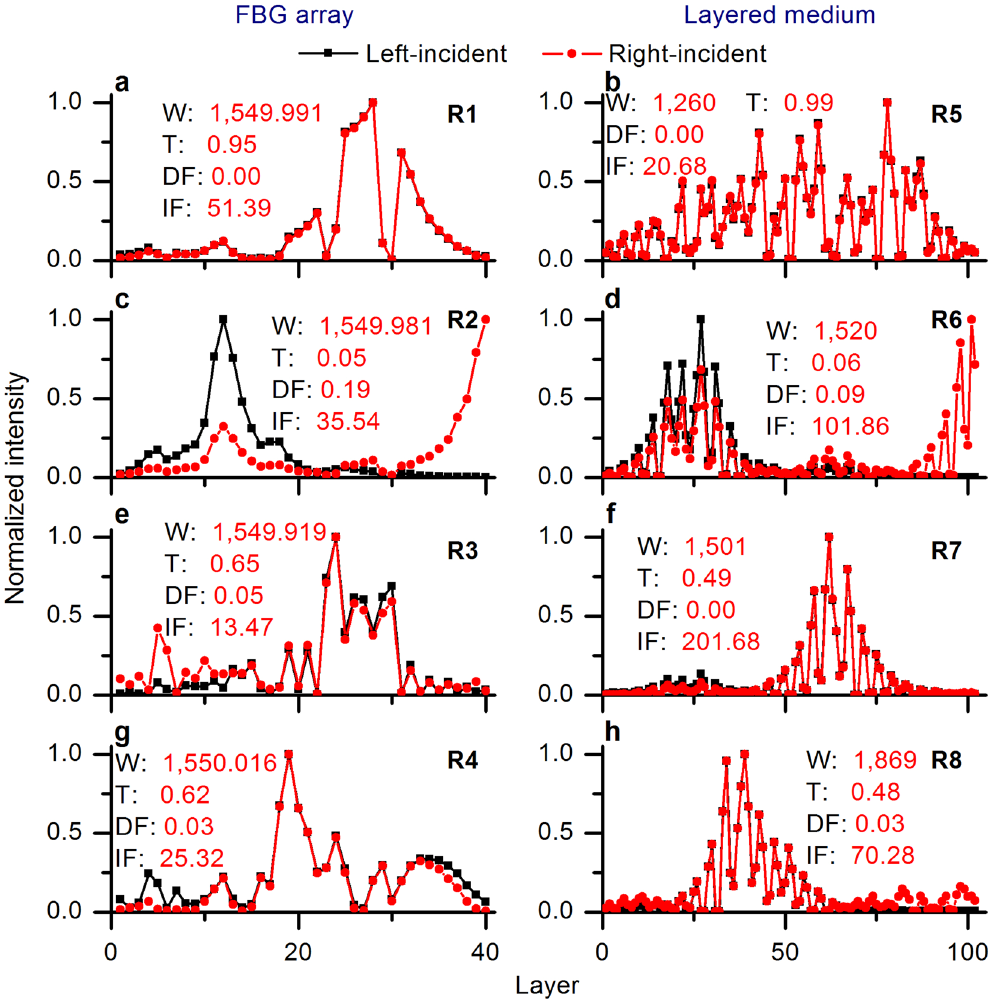
Figure 3. Normalized bi-directional intensity distributions in the FBG array and the layered medium. (a ) R1. ( b ) R5. ( c ) R2. ( d ) R6. ( e ) R3. ( f ) R7. ( g ) R4. ( h ) R8. W: wavelength in nm, T: transmission, DF: deviation factor, IF: intensity